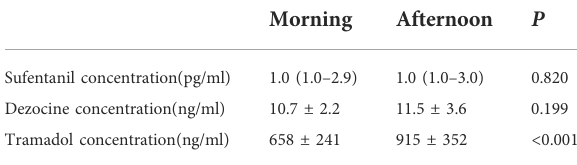
TABLE 3 Comparisons of blood detection results between the morning and afternoon groups after different analgesic